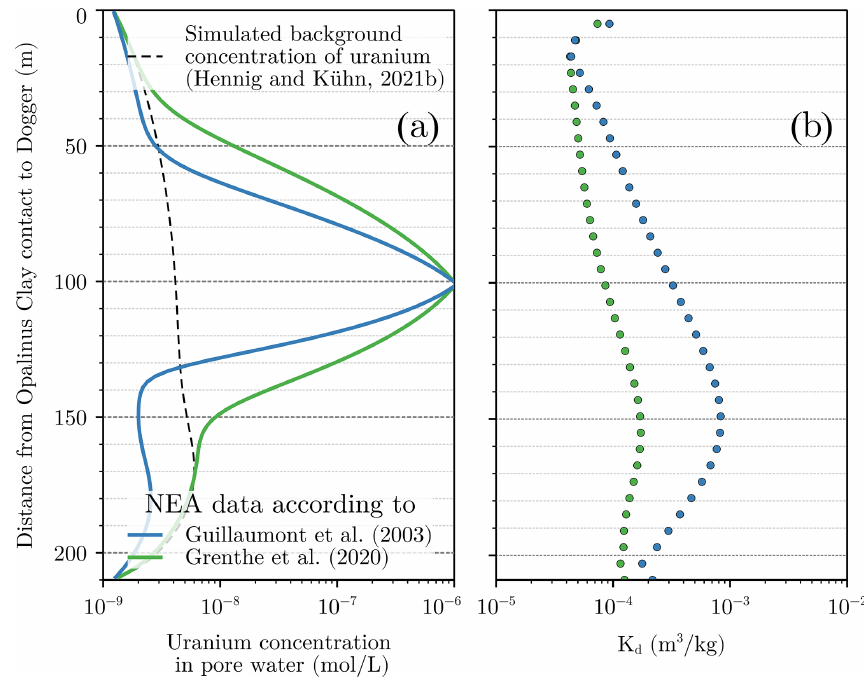
Figure 2. Changes in the speciation alter the sorption behaviour, and thus migration lengths. Uranium migrates farther through the Opalinus Clay (a) using the thermodynamic NEA data according to Grenthe et al. (2020) with the neutral ternary uranyl complex as predominant species (green lines) compared to the simulations of Hennig and Kühn (2021b), that are dominated by the anionic complex (blue lines), following the data of Guillaumont et al. (2003). The change in speciation is associated with a decrease in sorption capacity (b) represented by the distribution coefficients K d (m 3 kg − 1 ) calculated from